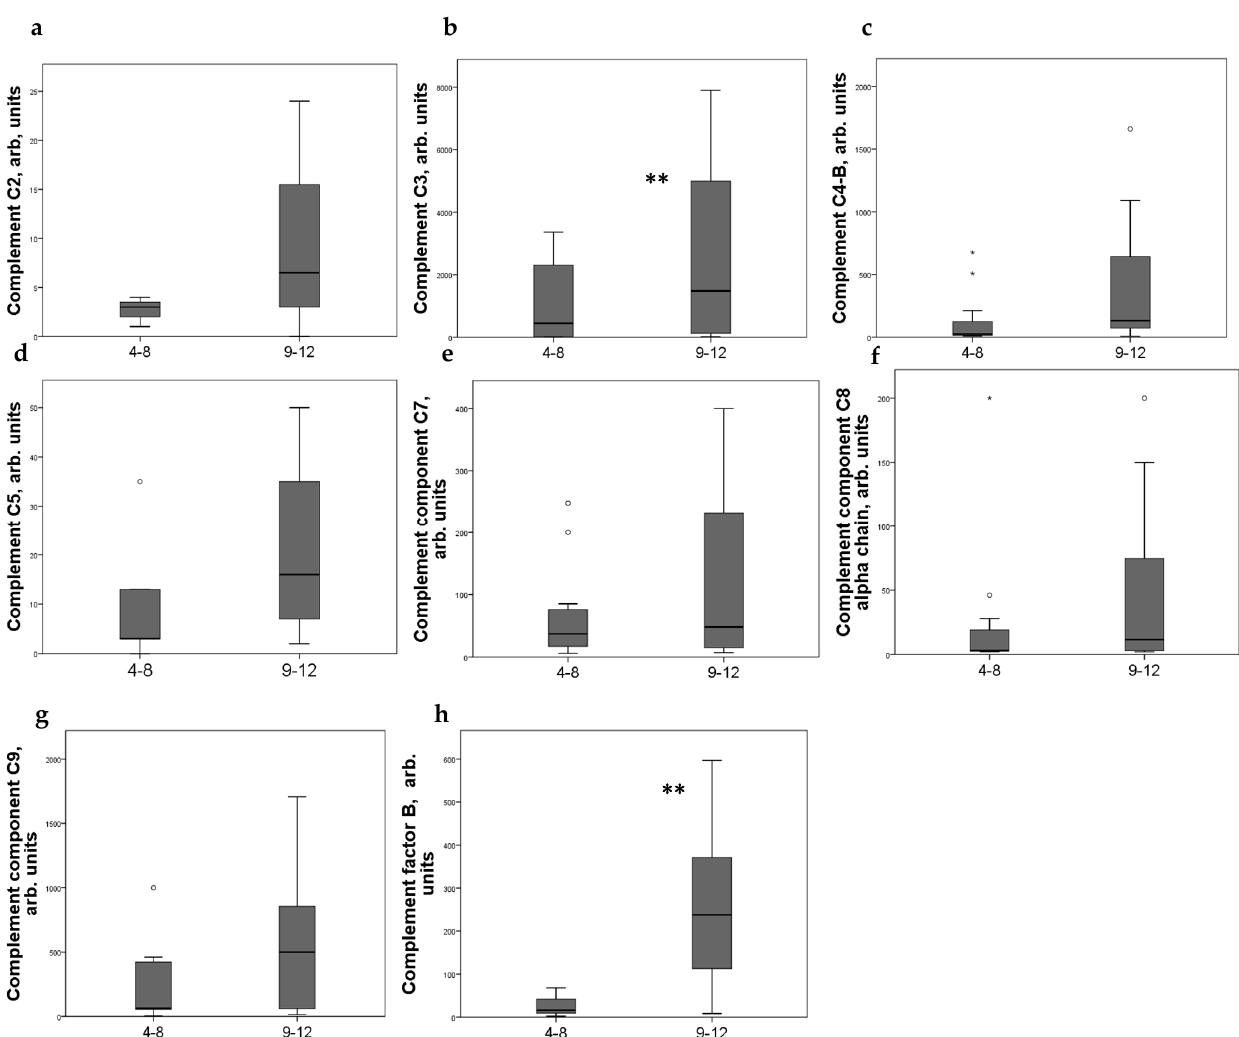
Figure 3. Components of complement in urine of patients ( a ) C2; ( b ) C3; ( c ) C4-b; ( d ) C5; ( e ) C7; ( f ) C8 alfa chain; ( g ) C9; ( h ) factor B with different interstitial CD44 expression score. Boxplots above present the results of Kruskal–Wallis test of parameters for independent samples with different CD44+ expression score. Center line indicates median, top of box indicates the 75th percentile, bottom of box indicates the 25th percentile, whiskers indicate the 10th and 90th percentiles, asterisk indicates extreme values (more than 3 interquartile ranges), and circles indicate outliers (between 1.5 and 3 interquartile ranges). ** p < 0.05. Table 2. Correlations between CD44 expression in parietal epithelial cells, mesangial cells ant interstitial cells, and clinical and laboratory data in different glomerulopathies (n = CD44+ expression in MC was associated with hematuria and % of glomerulosclerosis, CD44 interstitial expression – 179 with tubule-interstitial fibrosis (TIF) score. Podocytes showed variable expression of CD44, but no significant 180 correlations with these laboratory parameters were found. (Table 2).